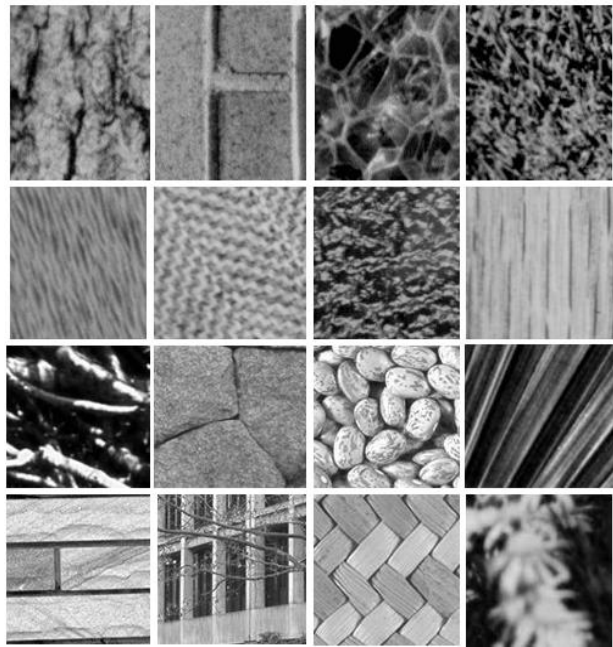
Figure 5. Some sample images from Brodatz and MIT- Vistex datasets